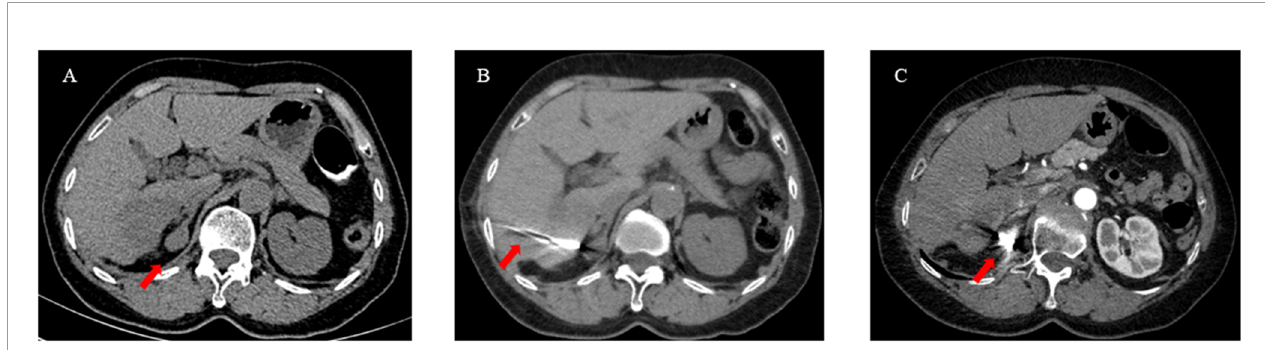
FIGURE 2 | A 63-year-old woman with HCC oligometastases. (A) The CT scan showed HCC oligometastasis (red arrow) in the right adrenal gland; (B) Under the guidance of CT, iodine 125 seeds were implanted into the metastatic by a 18G needle and turntable implantation gun (red arrow); (C) The CT scan showed that the Iodine 125 seeds were evenly distributed (red